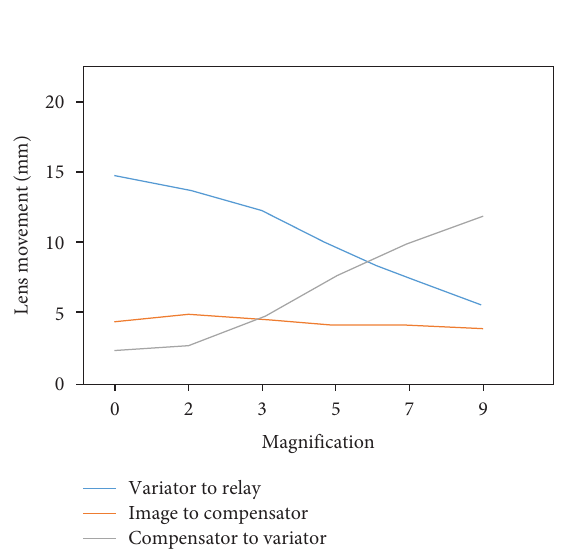
Figure 4: Movement distance of the variator and